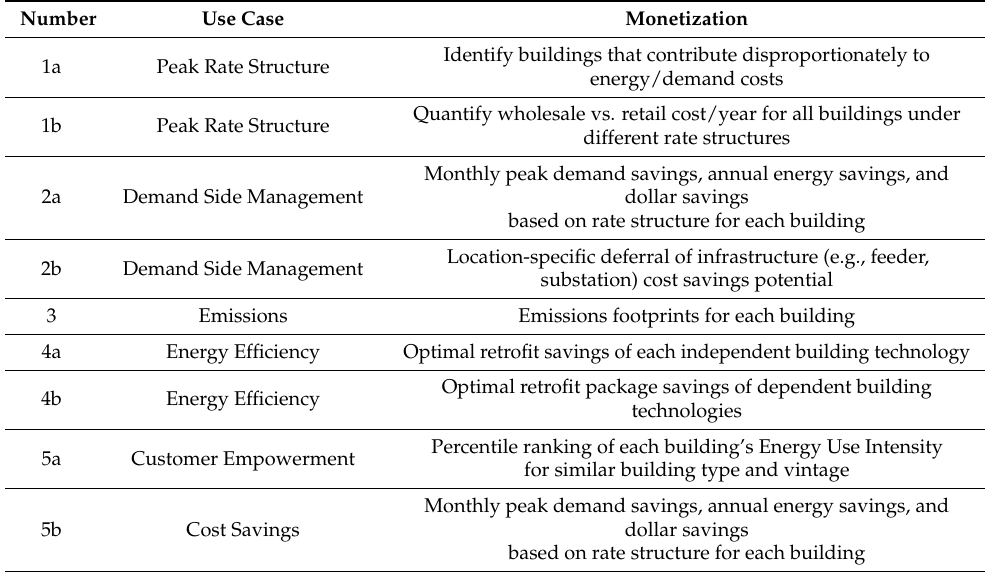
Table 1. Use cases and potential sources of savings considered in this study for each building technology further defined in Table 2.